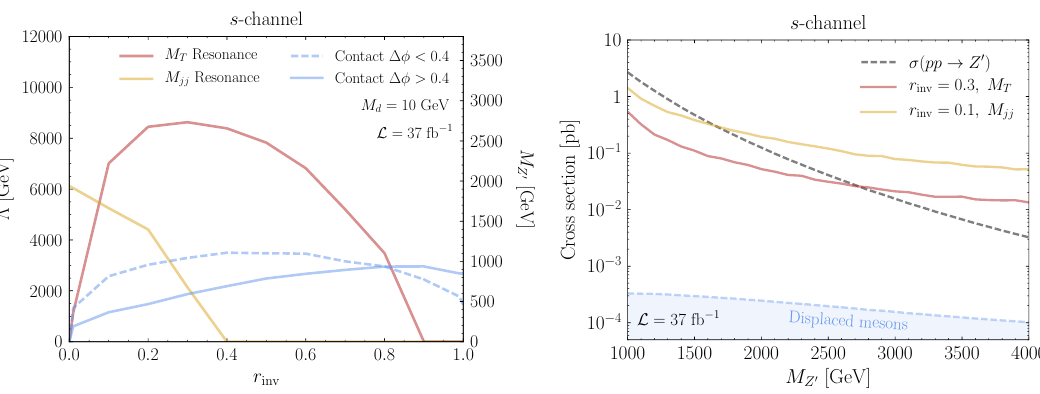
Figure 9 . (Left) Projected sensitivity on the operator scale (or Z 0 mass) for the s -channel model. The result for the M T ( M jj ) bump hunt is shown in red(yellow). The blue lines show the limits from the contact operator searches with (cid:1) (cid:30) > 0 : 4 (solid) or < 0 : 4 (dashed), as in (cid:12)gure 7. The mapping onto the contact operator limit is (cid:3) = M Z 0 = p g q g (cid:31) . (Right) The 95% exclusion limits on the production cross section as a function of M Z 0 for r inv = 0 : 1 or 0 : 3 using the M jj or M T search, respectively. The dashed black line indicates the production cross section for the Z 0 model, assuming g q = 0 : 1 and g (cid:31) = 1. The blue shaded region indicates where a search targeting displaced vector mesons may improve the sensitivity reach. Note that this region is a rough estimate and is quite sensitive to the vector meson mass, which we take to be m (cid:26) = 20 GeV d